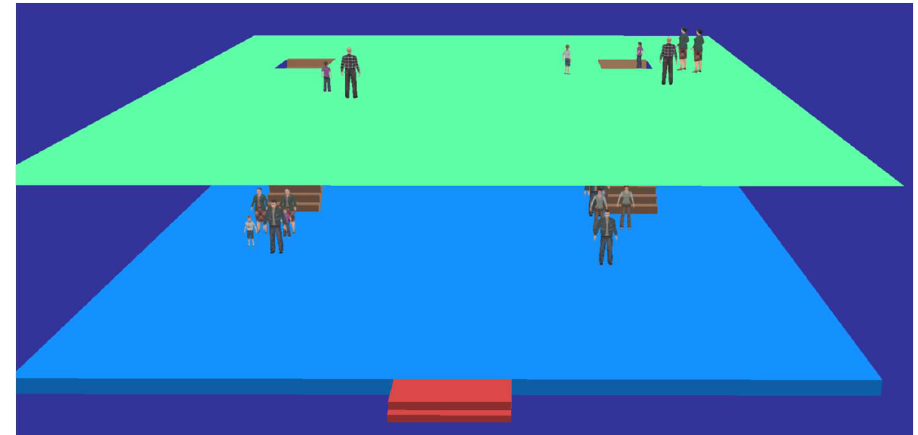
Figure 7. The 3D scene of individual behavior simulation for Case 1, in which individuals move along the shortest path from their initial positions to the exit.